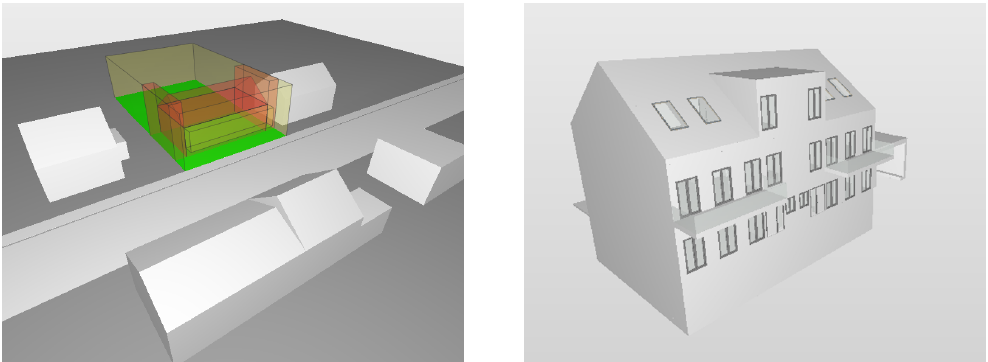
Figure 2. The ideal process of building approval uses the IFC (industry foundation classes) standard to formulate building requirements ( left ), as well as exemplary candidate models ( right ) for approval. The geometric requirements model consists mainly of spaces defining permitted and prohibited spaces and areas.